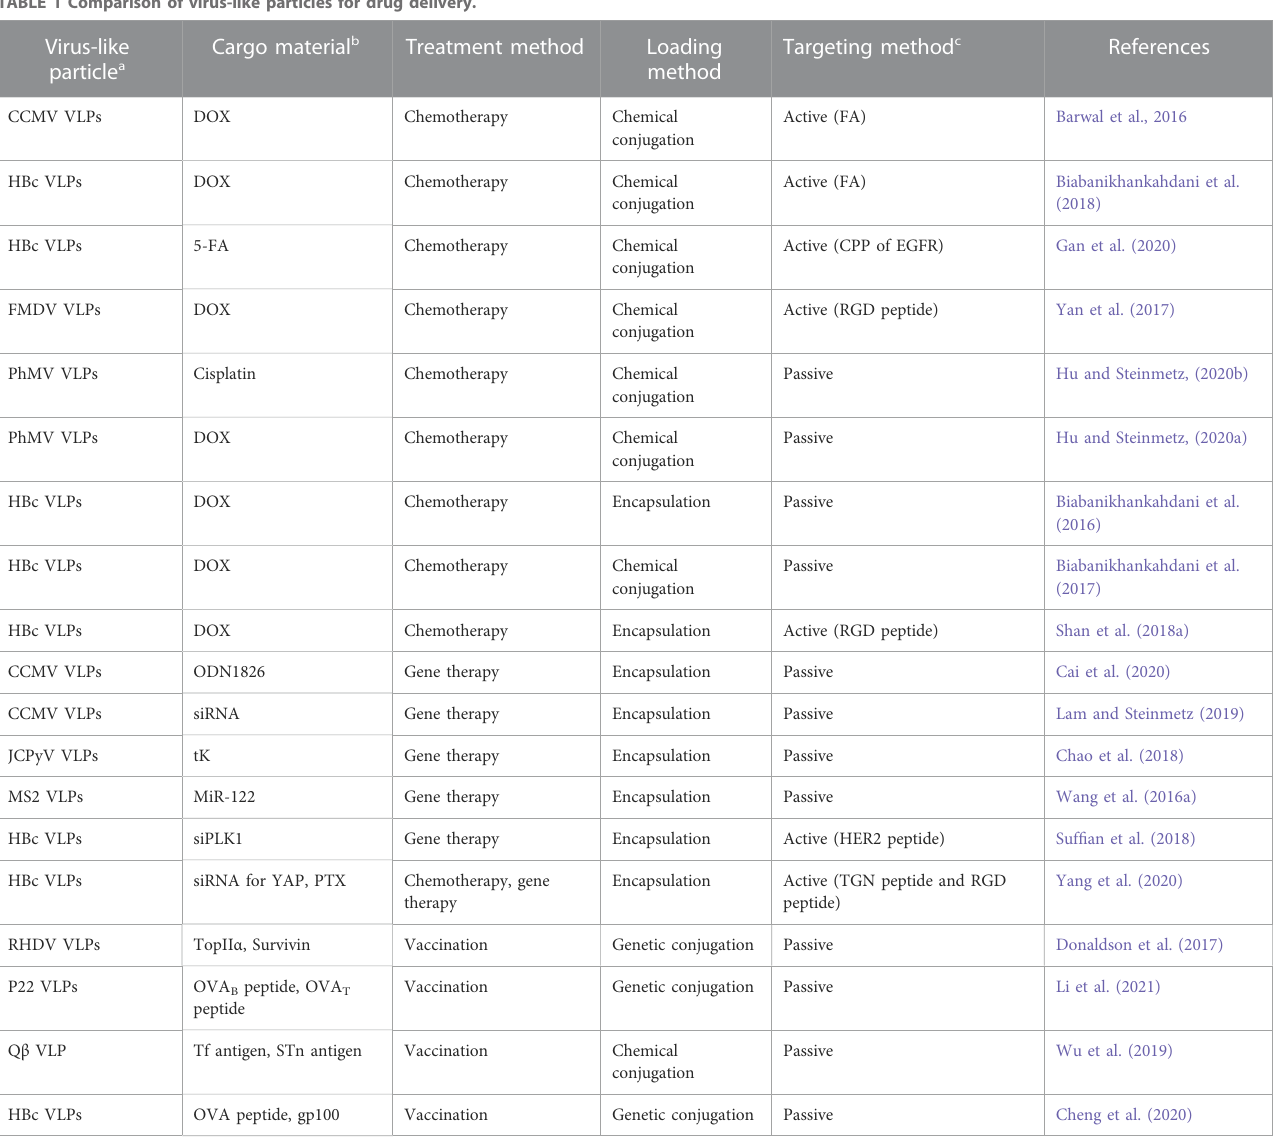
TABLE 1 Comparison of virus-like particles for drug delivery. Virus-like particle